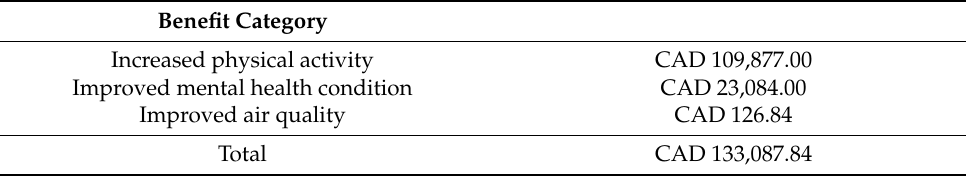
Table 2. Summary of economic benefits of proposed urban park (CAD,